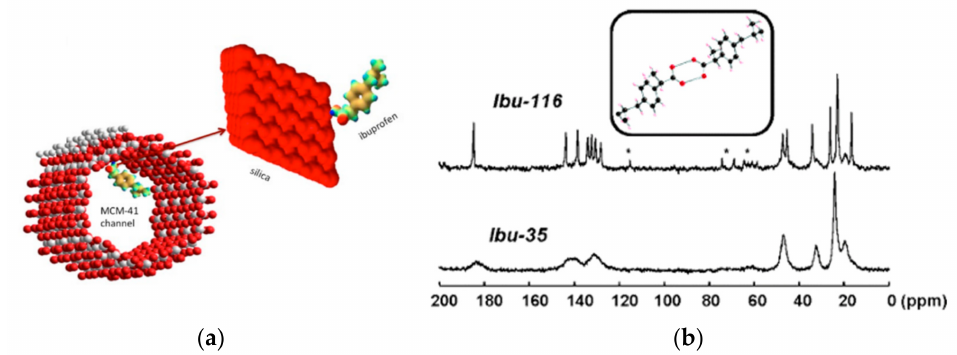
Figure 7. ( a ) Adsorption of a molecule of ibuprofen within the MCM-41 channels by electrostatic interactions; ( b ) 13 C CPMAS NMR spectra of Ibu-116 and Ibu-35 [30]. The stars indicate the presence of spinning sidebands. (Reprinted with permission from T. Azaïs, C. Tourn é -P é teilh, F. Aussenac, N. Baccile, C. Coelho, J.-M. Devoisselle, F. Babonneau, Chem. Mater. 2006 , 18, 6382. Copyright © 2006, American Chemical Society).